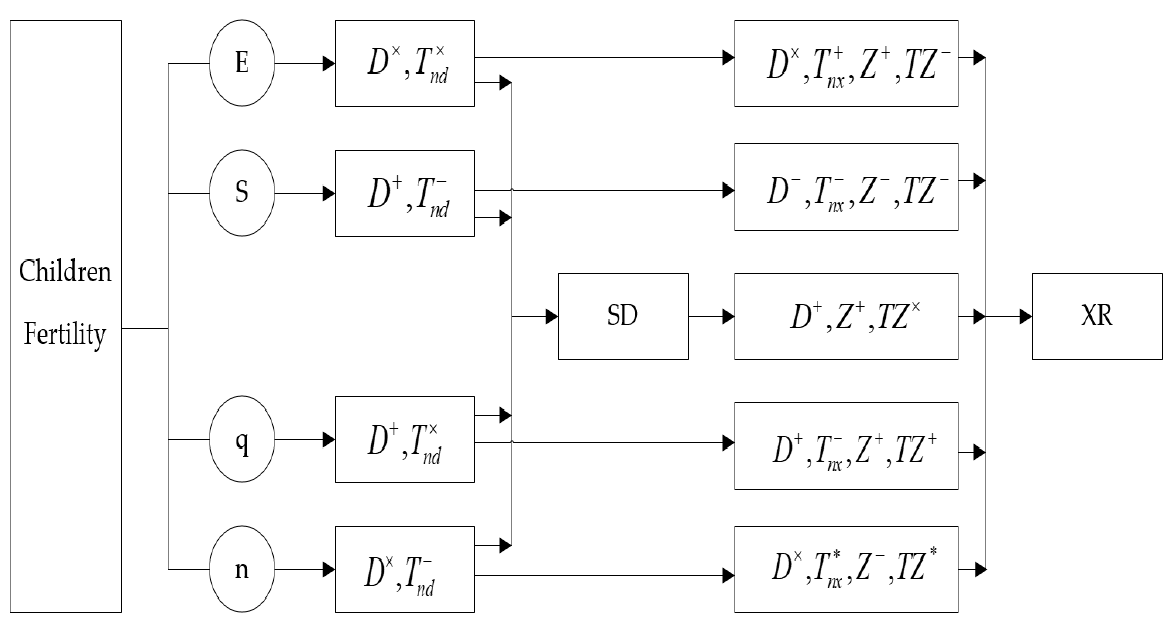
Figure 5. The actual mechanism and transmission path of children’s value influencing farmers’ social trust. Note: (1) E, S, and q denote the economic, social, and emotional values of children’s fertility; n represents the number of children, SD represents social status, and XR represents social trust; (2) D signifies direct mechanism, T nd represents the child’s value–social status adjustment mechanism, T nx represents the child’s value–social trust adjustment mechanism, Z denotes the intermediary mechanism, and TZ indicates the mixed adjustment intermediary mechanism; (3) “*” indicates that the direction of action of the mechanism depends on the combination of parameters, and if the direction is uncertain, “+” indicates positive effect, “ − ” indicates negative effect and “ × ” indicates that the empirical test has no significant effect.